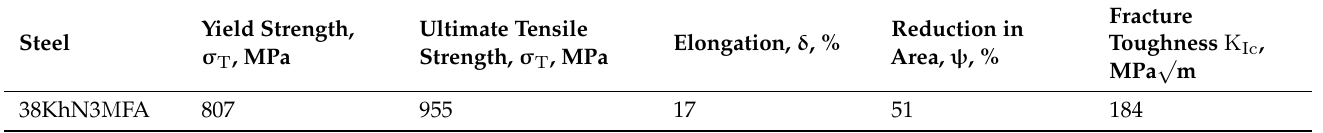
Table 2. Mechanical and physical properties of